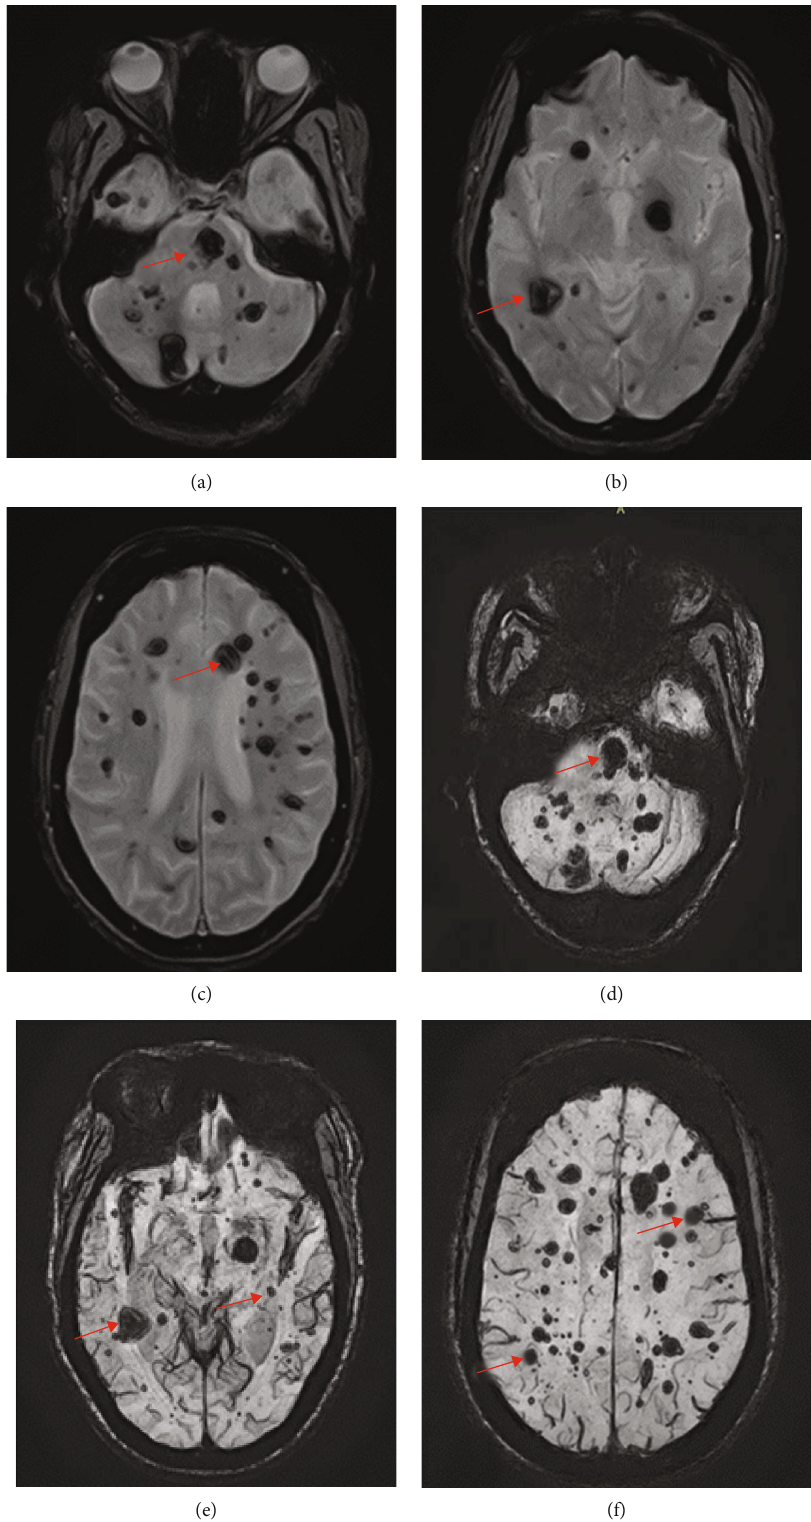
Figure 3: Axial brain MRI: (a – c) GRE/T2 ∗ and (d – f) SWI showing multiple di ff use cerebellar, pons, midbrain, bilateral basal ganglia, and cerebral lesions of varying sizes (red arrows) which became more prominent due to susceptibility artefacts (blooming) in keeping with multiple cerebral